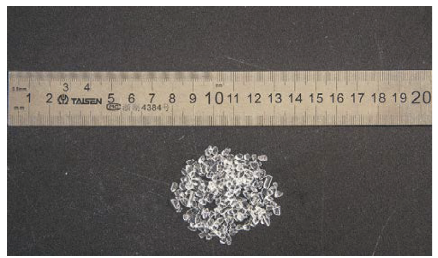
Figure 1: Selected particle of fused Table 1: Physical properties of the pore fluid.